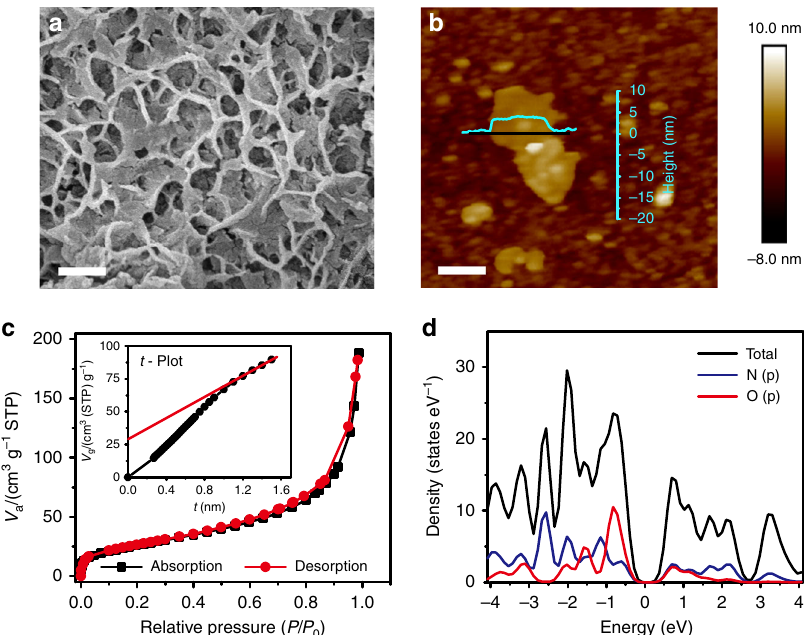
Fig. 2 Characterizations of TQBQ-COF. a The SEM image of TQBQ-COF powder. Scale bar, 100 nm. b AFM height image of TQBQ-COF material. The inserted line shows a height of ~5.0 nm for 16 monolayers of TQBQ-COF. Scale bar, 300 nm. c N 2 adsorption/desorption isotherms of the heat-treated TQBQ-COF. The inset is the t -Plot analyses of the heat-treated sample. d The DOS of the simulated AB stacking structure for